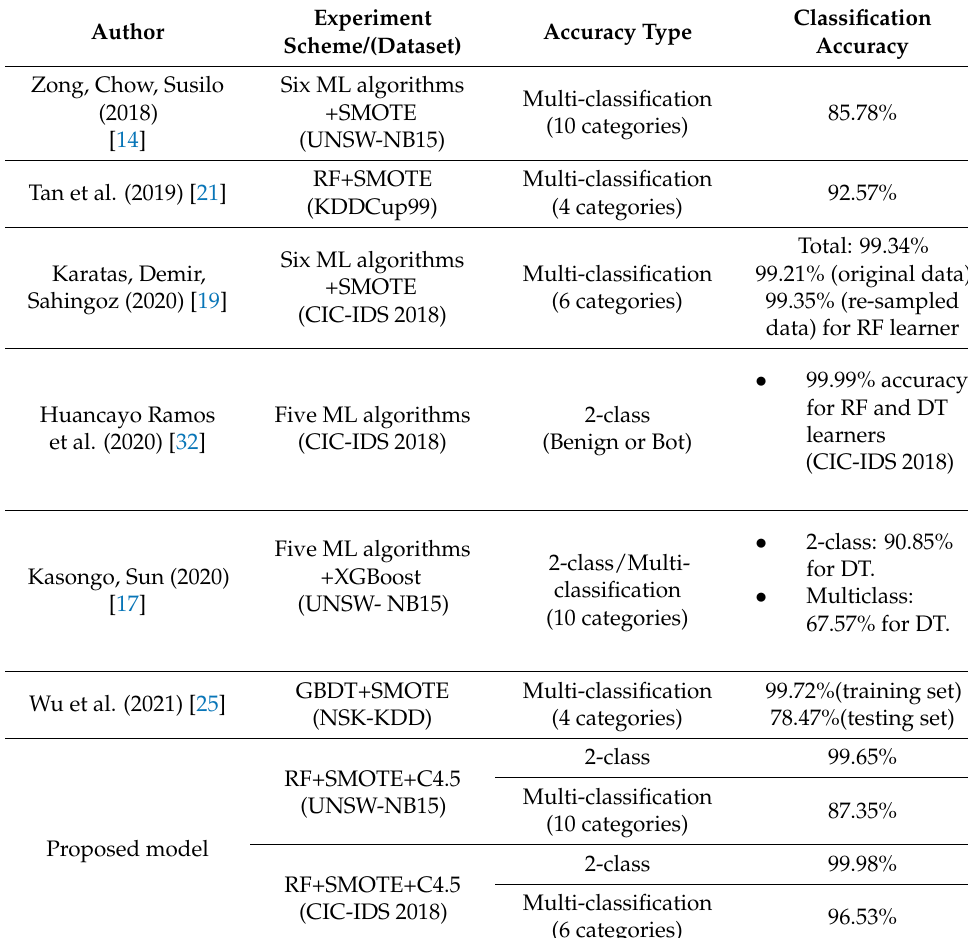
Table 14. Performance comparison of recent